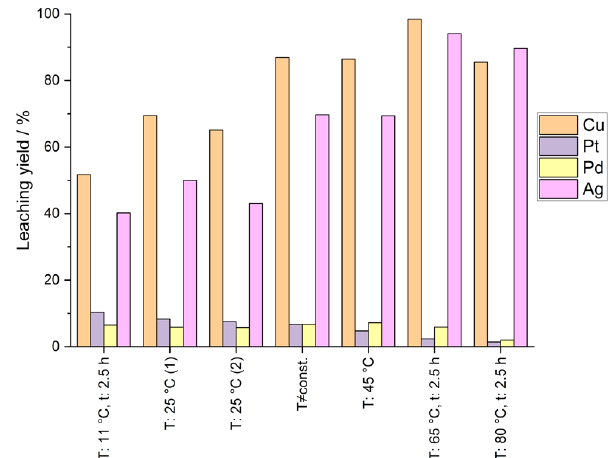
Figure 6. Leaching yields of several elements at different leaching temperatures (calculation based on analysis of liquid samples); solid conc.: 50 g/0.1 L; t: 5 h. on analysis of liquid samples); solid conc.: 50 g/0.1 L; t: 5 h.